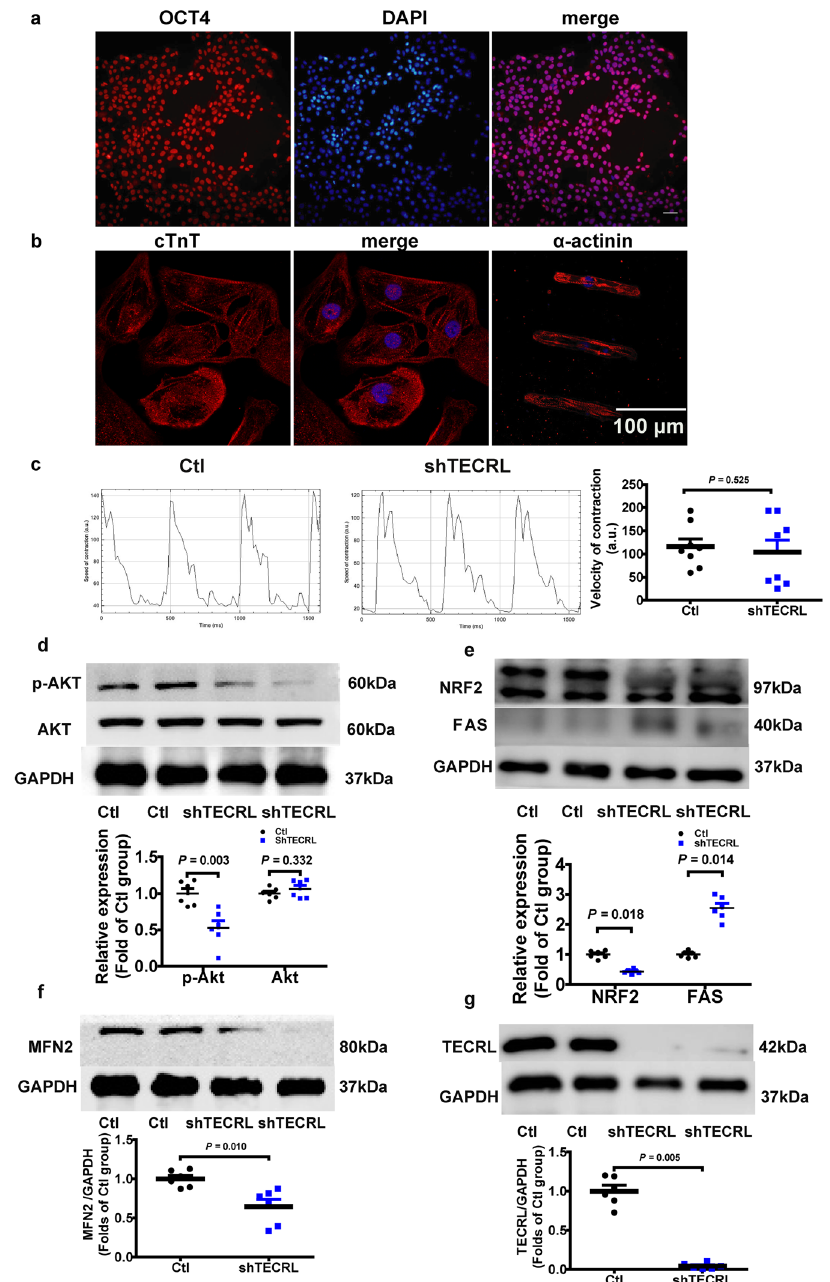
Fig. 6 Tecrl regulates PI3K/Akt signaling and mitochondrial fusion protein in hiPSC-CMs. a Representative immuno fl uorescence images of OCT4 in the hiPSCs ( n = 3). b Representative immuno fl uorescence images of α -actinin and cTnT in the hiPSC-CMs ( n = 6). c Representative images and quanti fi cation of the velocity of contraction and relaxation of hiPSC-CMs. d – g Representative immunoblotting images and quanti fi cation of the expression of p-AKT, NRF2, MFN2, FAS, and TECRL in hiPSC-CMs following TECRL knockdown. Values are mean ± SE. P < 0.05 was considered signi fi